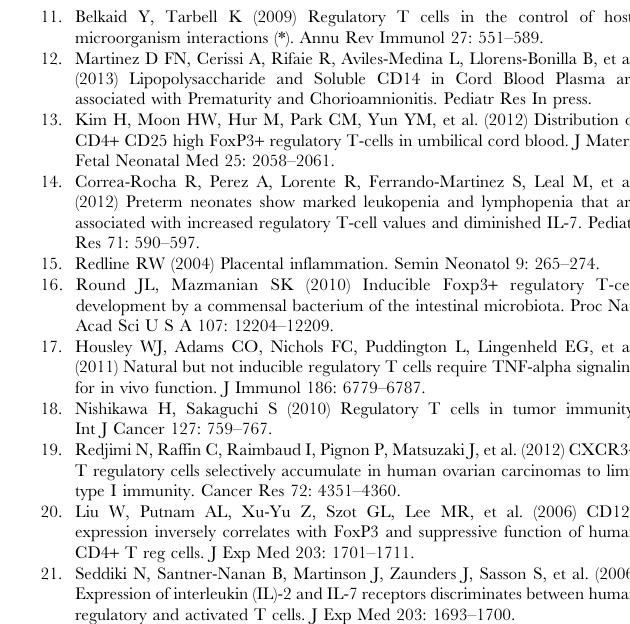
Figure S2 Term CB (first column) and preterm CB (second column). CD4 + Lymphocytes and Tregs were examined for expression of the surface marker CD31.